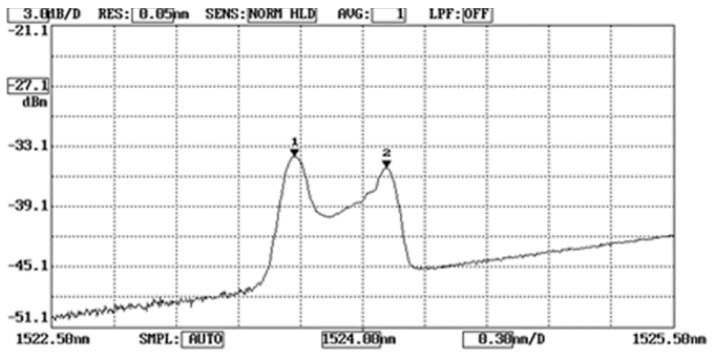
Figure 5. Optical spectrum reflected from the unbonded and bonded FBG due to a load of 102 N in the three-point bending test.